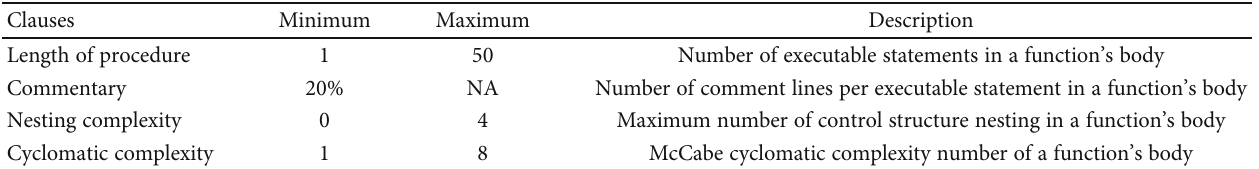
Table 1: Software quality metrics.